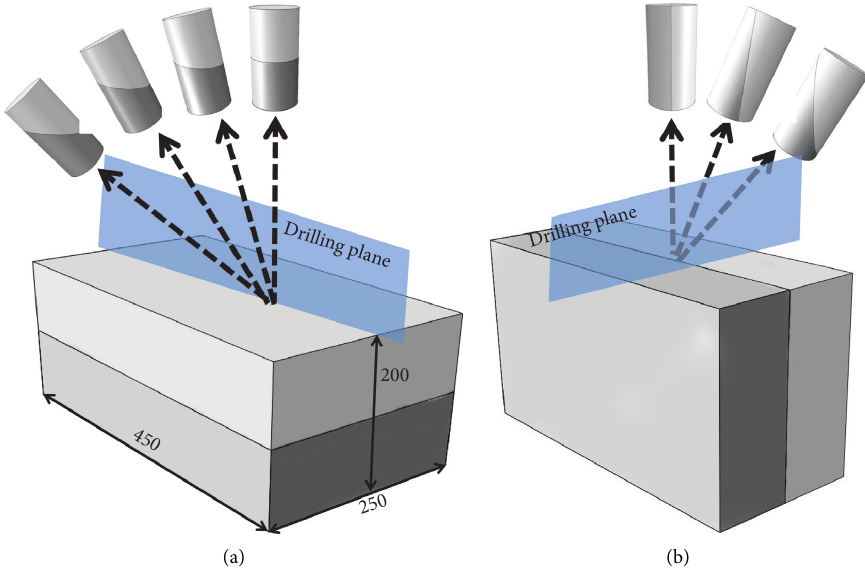
Figure 3: Drilling method of the composite rock sample. (a) 0 ° –45 ° and (b) 60 ° –90 ° .